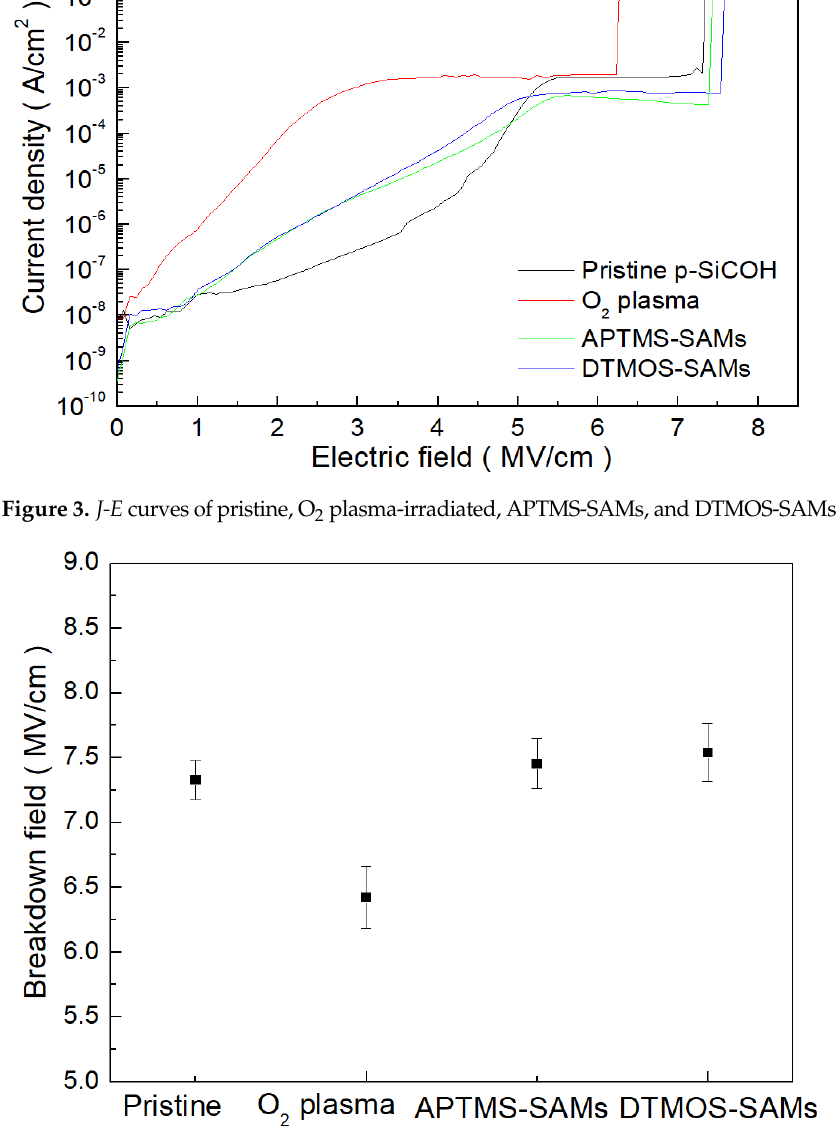
Figure 4. Comparison of breakdown fields of pristine, O 2 plasma-irradiated, APTMS-SAMs, and DTMOS-SAMs p-SiOCH films.